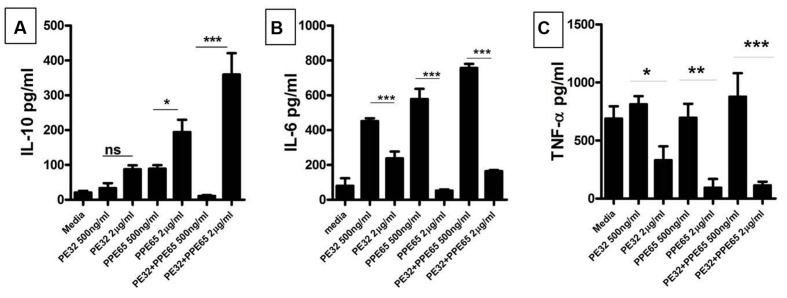
PE32 and PPE65 modulate the host immune pathway by suppressing pro inflammatory cytokine production. RAW 264.7 cells were treated with purified recombinant PE/PPE proteins in different concentration for 24 h, culture supernatants were collected for measuring various cytokine levels through sandwich ELISA. (A) PE32, PPE65 induce IL-10 level in RAW 264.7 cells as a direct function of protein concentration whether used singly or together. (B,C) Note the decrease in the level of Th1 cytokine (IL-6 and TNF-α) in RAW 264.7 cells with increase in protein concentration Experiments were performed at least twice; SEM is represented by error bar for biological triplicates. ∗p < 0.05, ∗∗p < 0.01, and ∗∗∗p < 0.001.